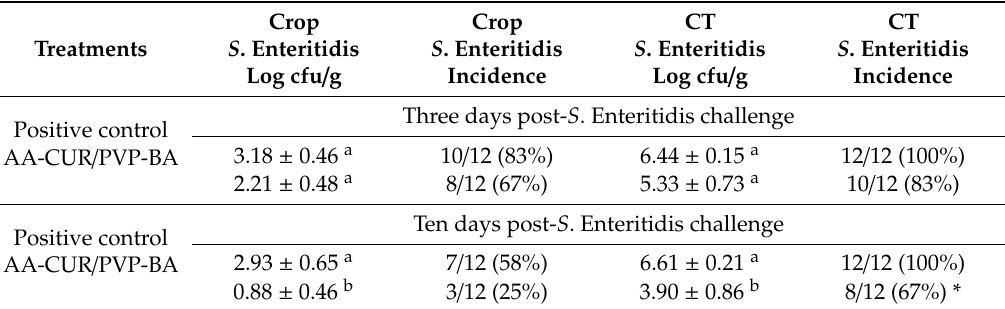
Therapeutic administration of a 0.1% mixture containing ascorbic acid (AA) and a solid dispersion of curcumin with polyvinylpyrrolidone (CUR / PVP, ratio 1:9) and boric acid (BA) (AA-CUR / PVP-BA) on crop and cecal tonsils (CT) colonization of Salmonella Enteritidis ( S . Enteritidis) 1 in broiler chickens at three and ten days post- S . Enteritidis challenge (experiment 2). Crop Crop S . Enteritidis Treatments Incidence Log cfu / g Three days post- S . Enteritidis challenge Positive control 3.18 ± 0.46 a AA-CUR / PVP-BA